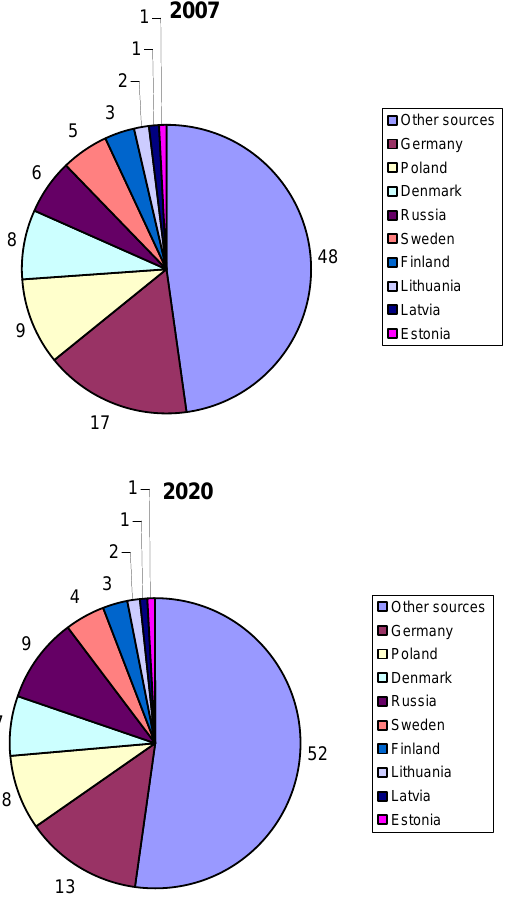
Figure 5. The nitrogen deposition to the Baltic Sea divided into the contribution from the nine bordering countries and other sources (i.e. from the remaining emissions in the model domain). The contributions are given in percent [%] for both the present day scenario and the projections for 2020. Each contributing country has the same colour in the two pies.